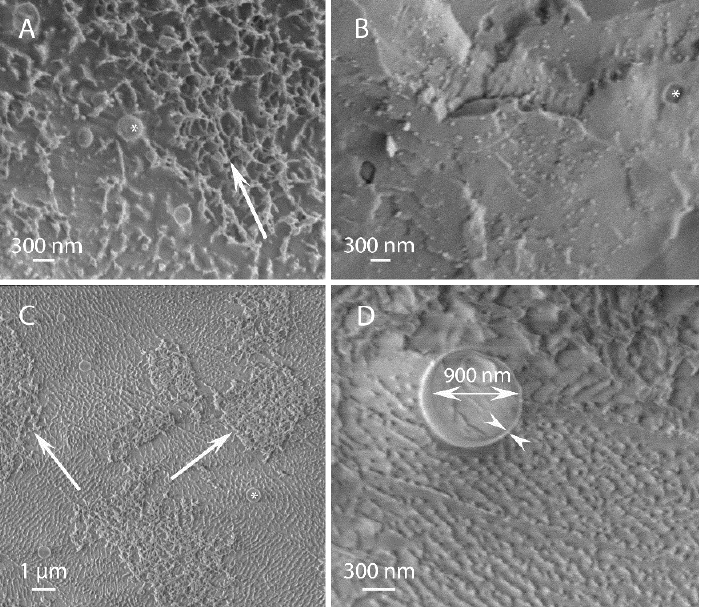
Figure 3. Cellulose coated microcapsule emulsions of TY ( A , B ) or EU ( C , D ) fabricated at a 1:1 cellu- lose:EO ratio, by HPH at 10,000 psi. The asterisks (in A – C ) mark the microcapsules. The single ar- rows (in A , C ) point to the cellulose network in the background. The outward and inward pointing double arrows (in D ) indicate the capsule diameter and shell thickness, respectively.